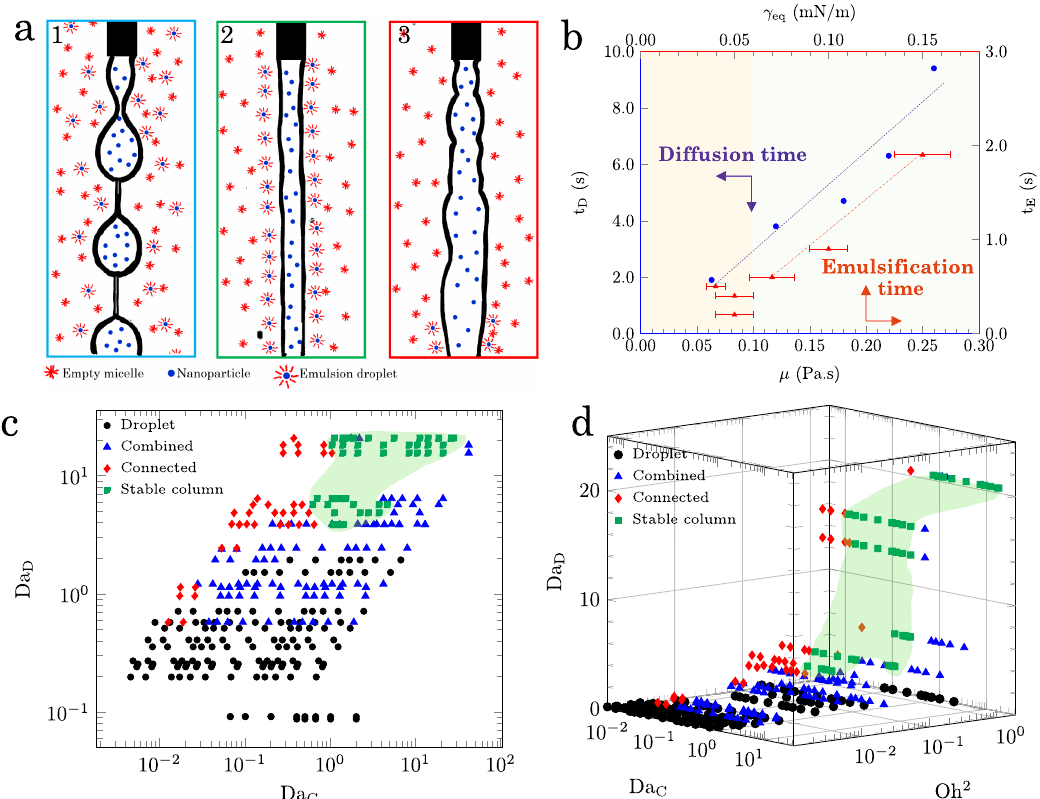
Fig. 3 Dimensional analysis of the fl ow regimes. a Schematic of the fl ow regime transition from BOAS to column and connected. a .1 The residence time is longer than the diffusion time. Emulsions are formed at the interface and diffuse to the bulk. a .2 The residence time is longer than the emulsi fi cation time and shorter than the diffusion time. Thus, emulsions are generated and remain at the interface. a The residence time is shorter than the emulsi fi cation time, so that there is not enough emulsion at the interface to stabilize the liquid fi laments. b Diffusion time, t D (left and bottom axis in blue), and emulsi fi cation time, t E (right and top axis in red), obtained from the fl ow regime transitions in (Fig. S22, Table S1). The slope of lines are 31.5 m s 2 /kg and 11.2 s 3 /g, respectively. The error bars represent the standard deviation of interfacial tension values of three systems that have a similar emulsi fi cation time scale. The yellow and green shaded zones represent regions where the emulsi fi cation time is constant and changes upon increasing the interfacial tension, respectively. c Relative importance of diffusion and emulsi fi cation time scales as depicted by the diffusion (Da D ) and convection (Da C ) Damköhler numbers. d 3D phase diagram of the fl ow regimes by considering the properties of the inner fl uid. The highlighted zone in green shows the region of liquid column formation. Source data are provided as a Source Data fi